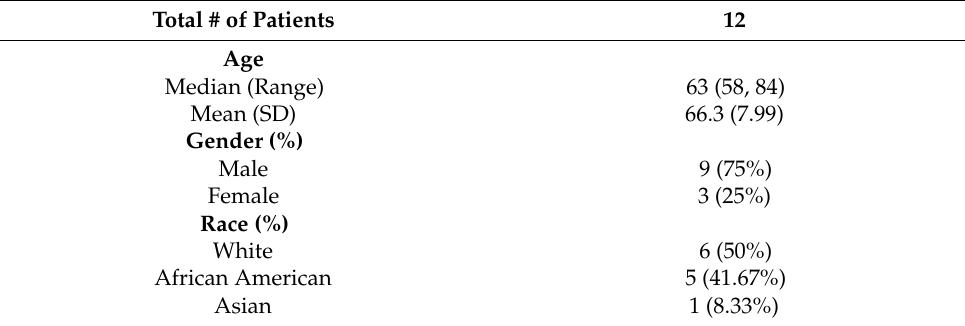
Table 1. Patient demographics data included in the study.